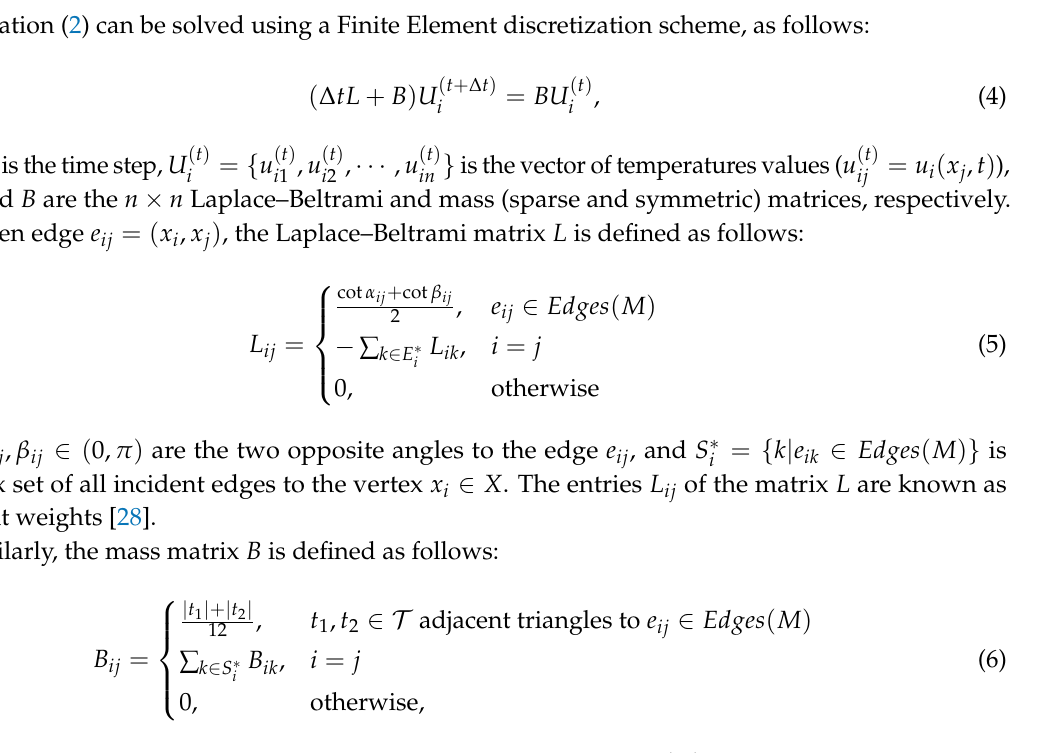
Figure 2. Heat kernel u i ( x , t ) for the vertex source x i ( t > 0). Heat dissipates from x i